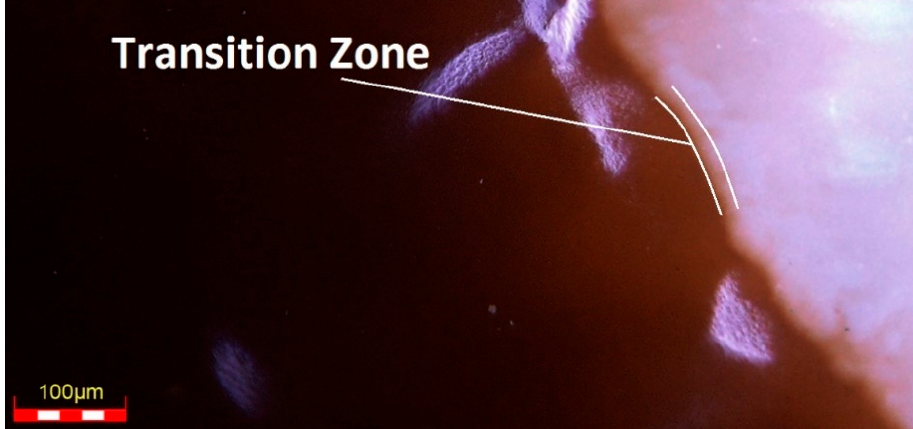
Figure 4. Optical microscope image of the stabilization “Transition Zone”.